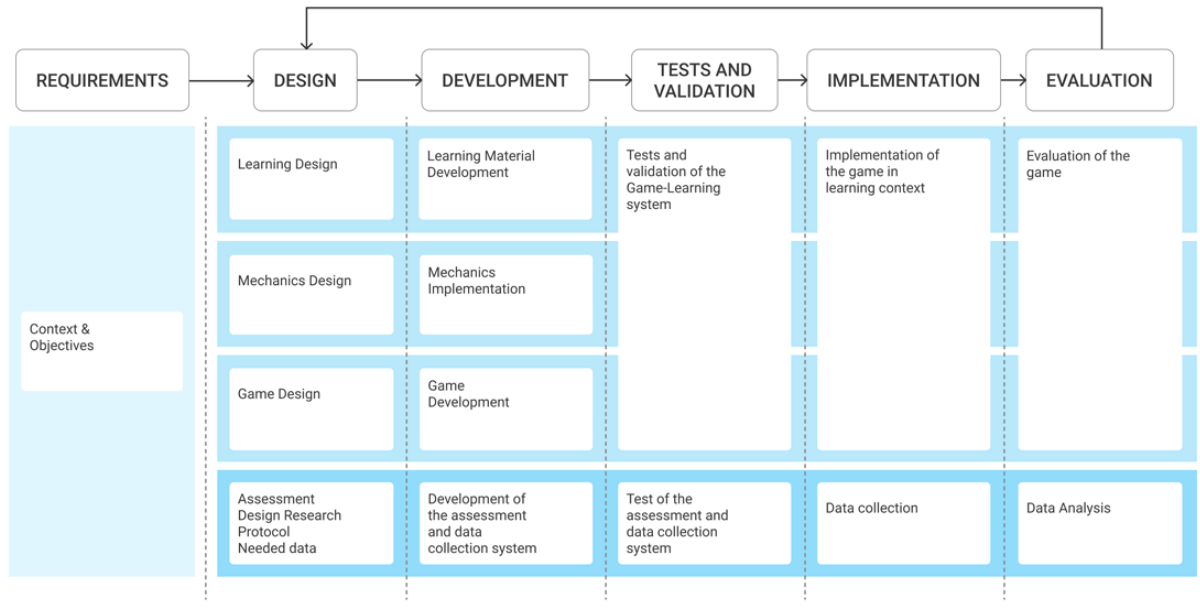
Figure 8. Extension of the co.LAB framework along the entire serious game life